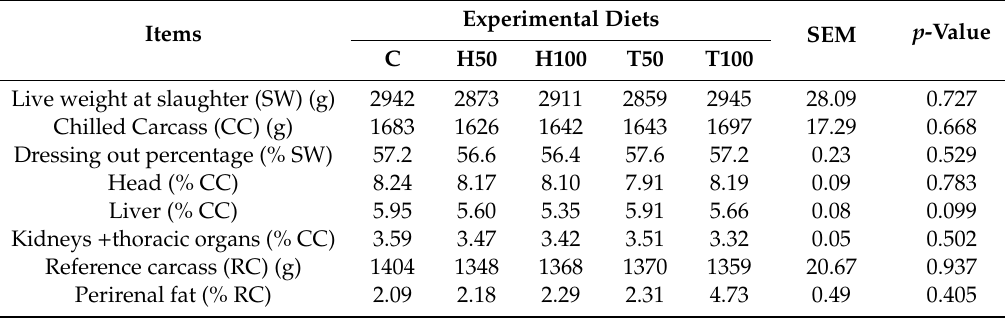
Table 3. Slaughter traits of the rabbits fed experimental diets (n = 20 rabbits / group).